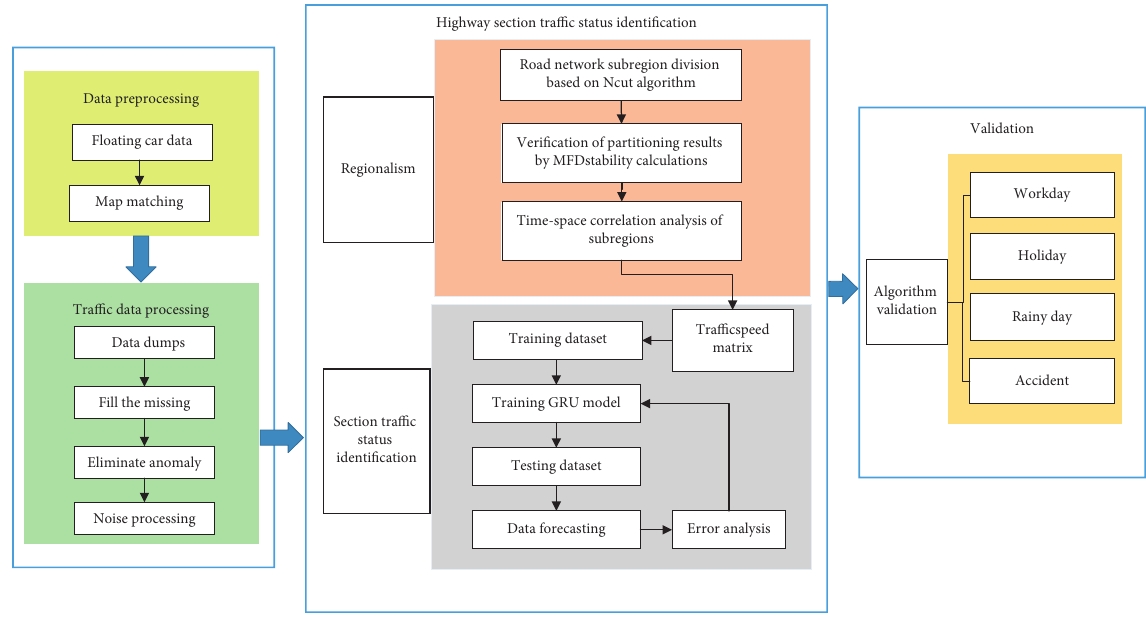
Figure 1: The technical framework of the